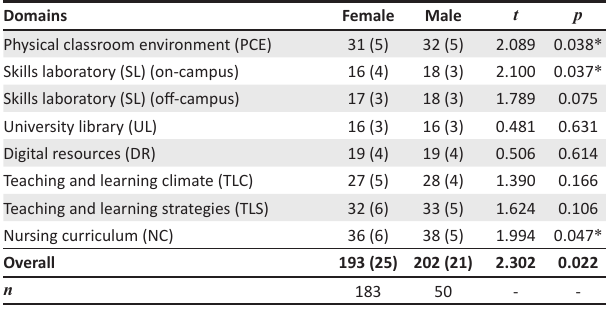
TABLE 4: Mean score (standard deviation) and overall scores by gender ( N = 232).